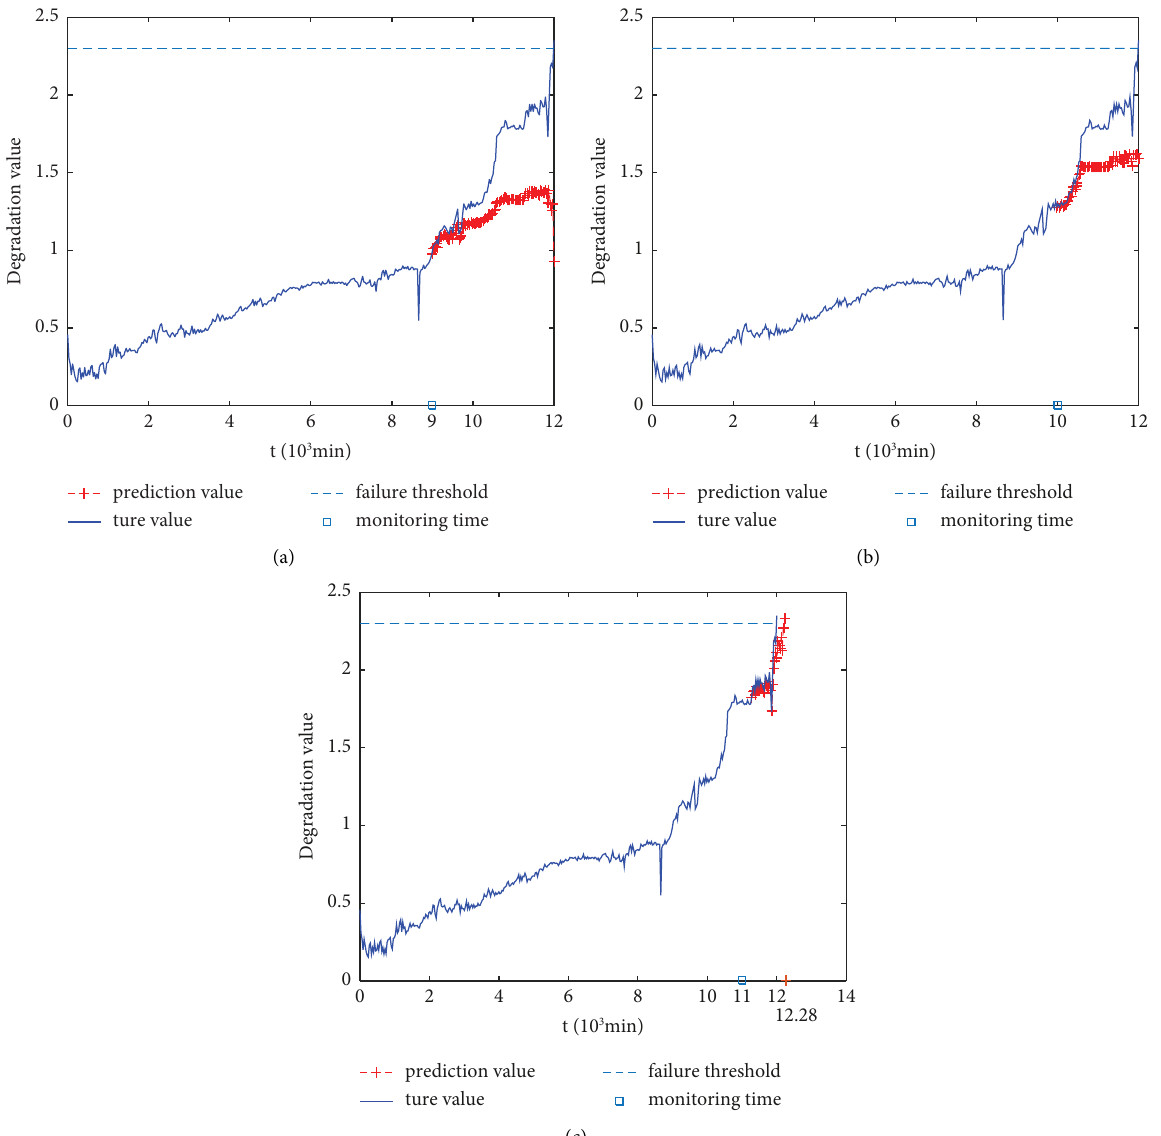
Figure 10: Te degenerate states of the CNN model at diferent times. (a) t